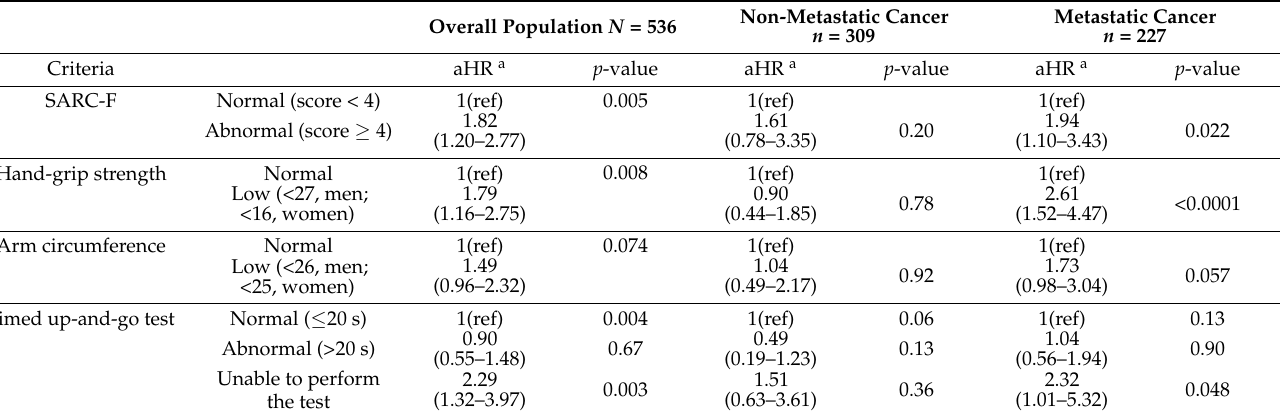
Table 3. Multivariate analysis of criteria for probable sarcopenia as predictors of 6-month mortality.